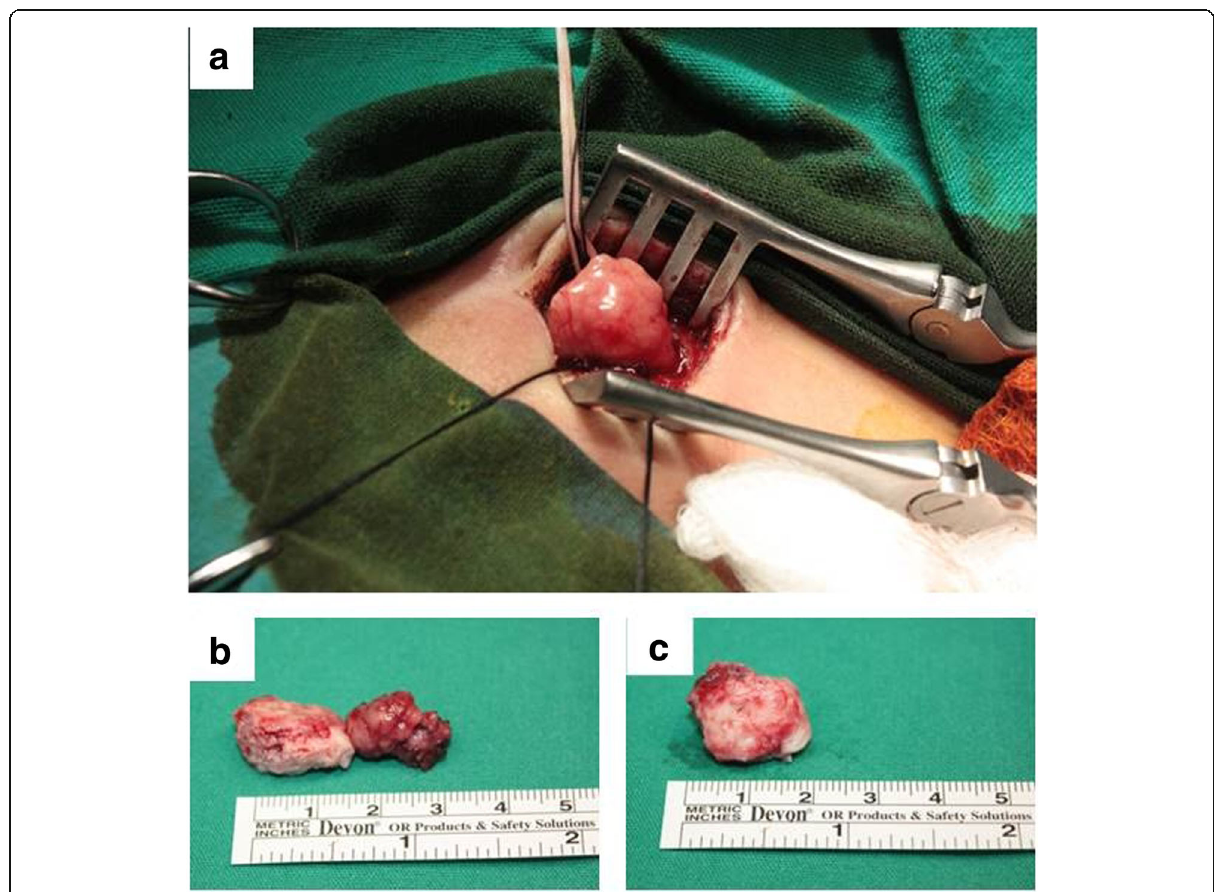
Fig. 2 a Intraoperative image: the tumour was discovered in the right lacrimal fossa. b Gross photograph of the tumour and right lacrimal gland following excision. c Macroscopic aspect of the excised tumour mass showing its bosselated surface, purple greyish colour with yellow areas and elastic consistency. It was 2,5 × 1,7 × 1,5 cm in